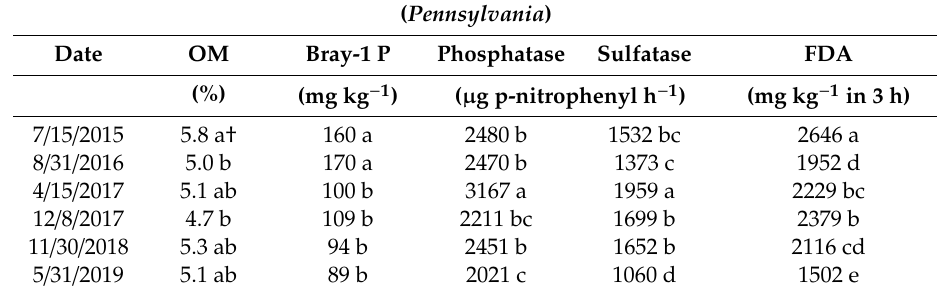
Table 7. OM, Bray-1 P, phosphatase, sulfatase, and FDA as a function of sampling date in Pennsylvania site.